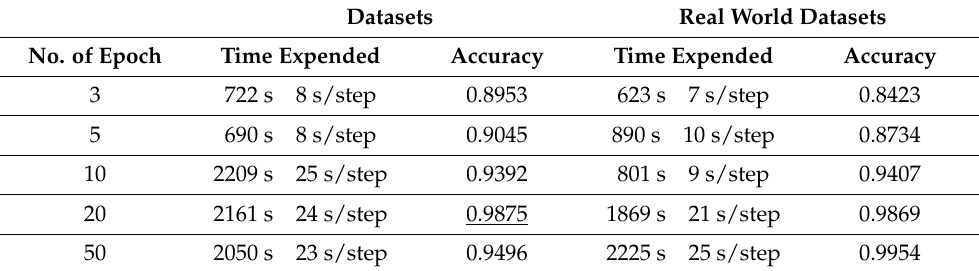
Table 5. No. of epochs with respect to training accuracy. Table 4. Summary of the predictive performance of the pre-trained models, AlexNet, VGG16, and ResNet34, and the proposed method.